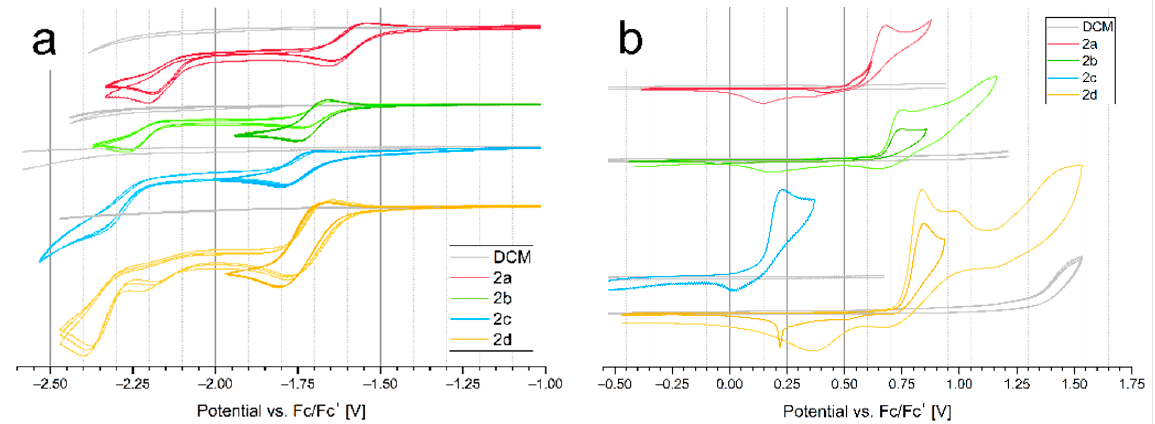
Figure 3. ( a ) The Cyclic Voltammetry (CV) of reduction of monomers versus ferrocene redox couple, concentration 1 mmol/dm 3 in DCM, 100 mV/s and background (gray line); ( b ) the CV of oxidation of monomers versus ferrocene redox couple, concentration 1 mmol/dm 3 in DCM, 100 mV/s and background (gray line).